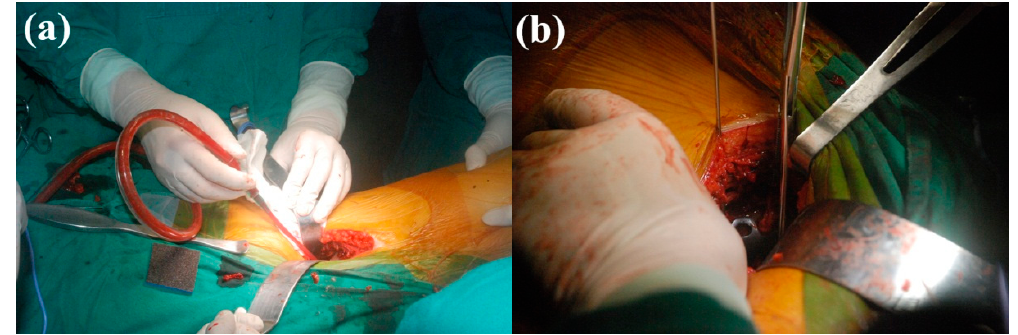
Figure 8. Clinical operation of the 3D-printed pelvic bone plate. ( a ) The first stage of the surgery; ( b ) The placement of the customized Bone Plate.